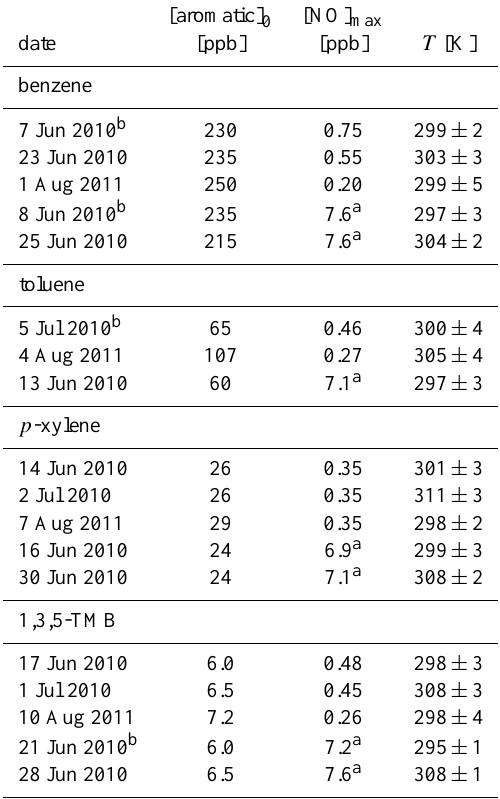
Table 2. Compilation of SAPHIR experiments with starting concen- trations of aromatic hydrocarbons ([aromatic] 0 ). These concentra- tions were calculated from the initial increase of k OH upon addition of reactants using OH rate constants from MCMv3.2; [NO] max de- notes peak NO concentration during the experiments. Temperatures are mean values covering the experiment periods after injection of aromatics. Error bars correspond to minimum and maximum tem- peratures.